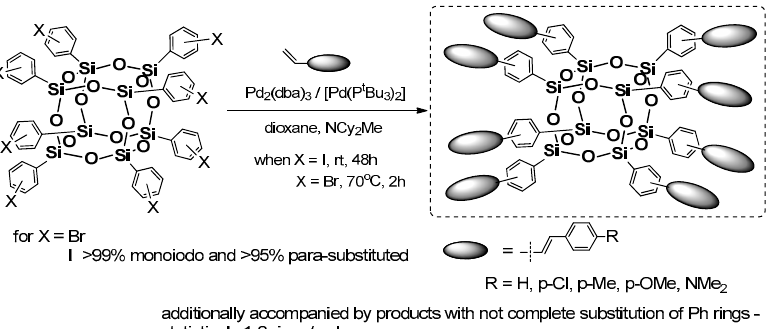
Figure 11. Heck coupling using halogenophenylPOSS reagents.